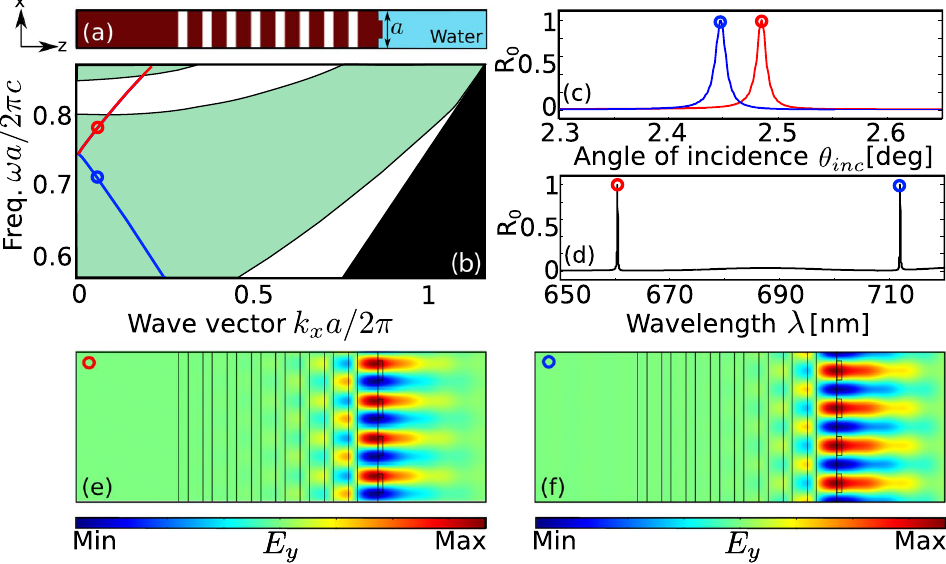
Figure 2. Leaky Bloch surface wave at φ = 0°. ( a ) TiO 2 -SiO 2 multilayer with grating on the top layer. ( b ) Dispersion curves of the leaky BSWs supported by the structure. The green region is the radiative region ( c , d ) Reflectance of BSW as a function of incident angle and wavelength respectively. ( e , f ) Electric field profiles of BSW modes. The red and blue circles at the resonance peaks represent the reflectance at the corresponding circles in ( b